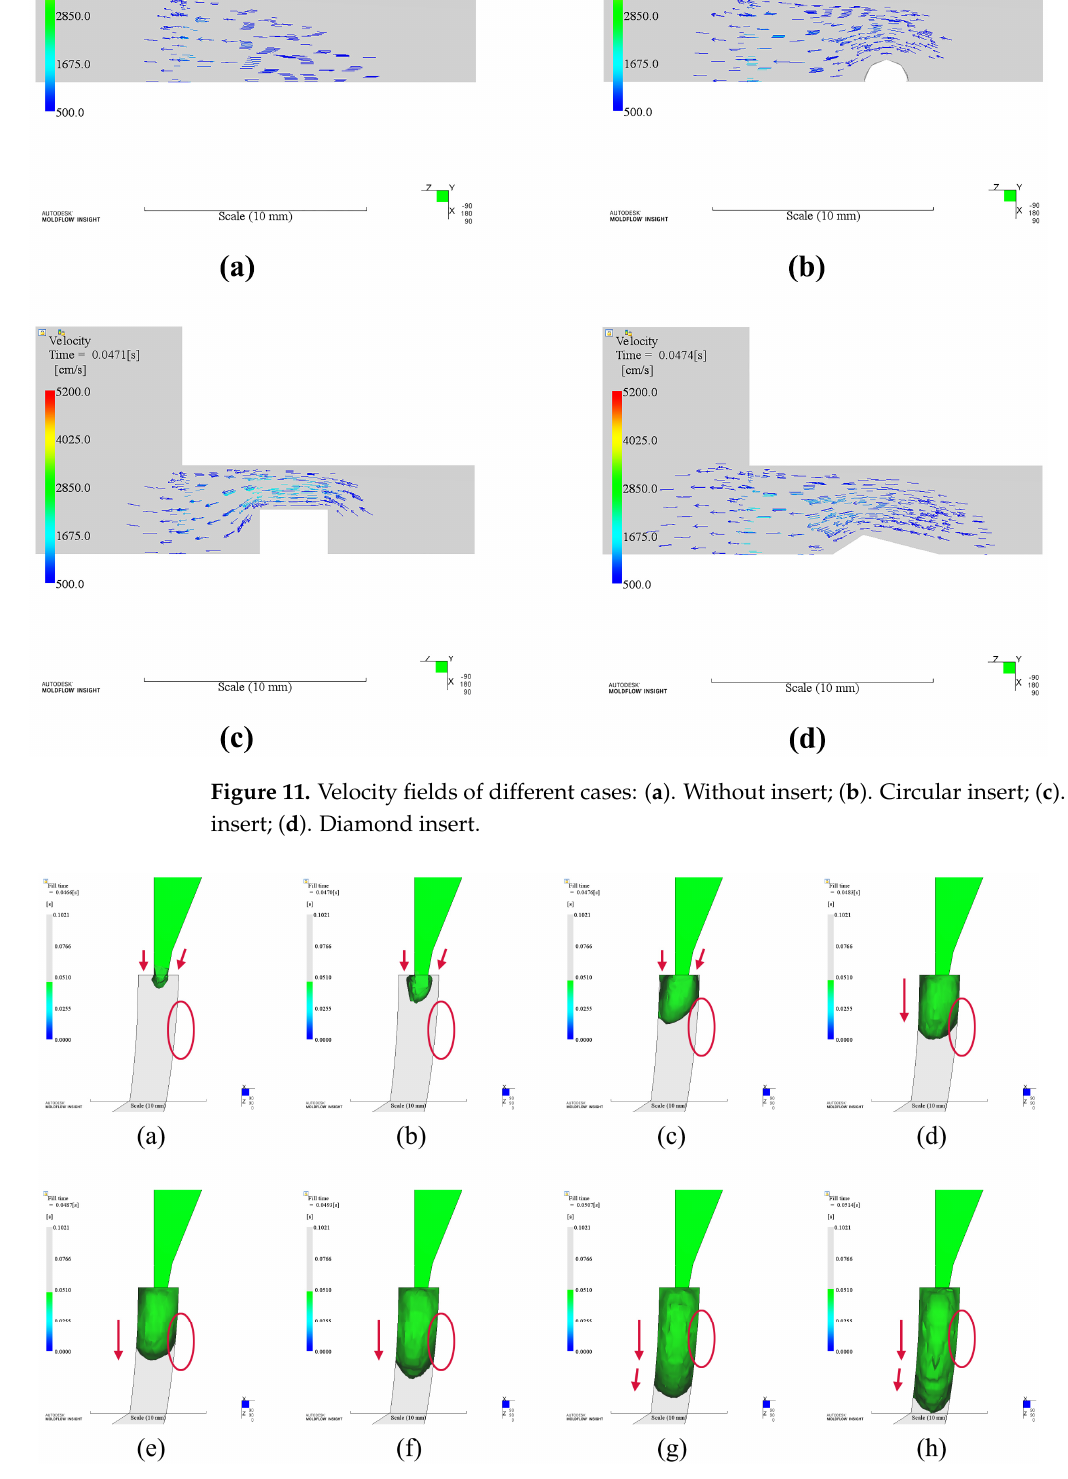
Figure 12. Flow progress of the melts after entering the cavity in the case of without insert.